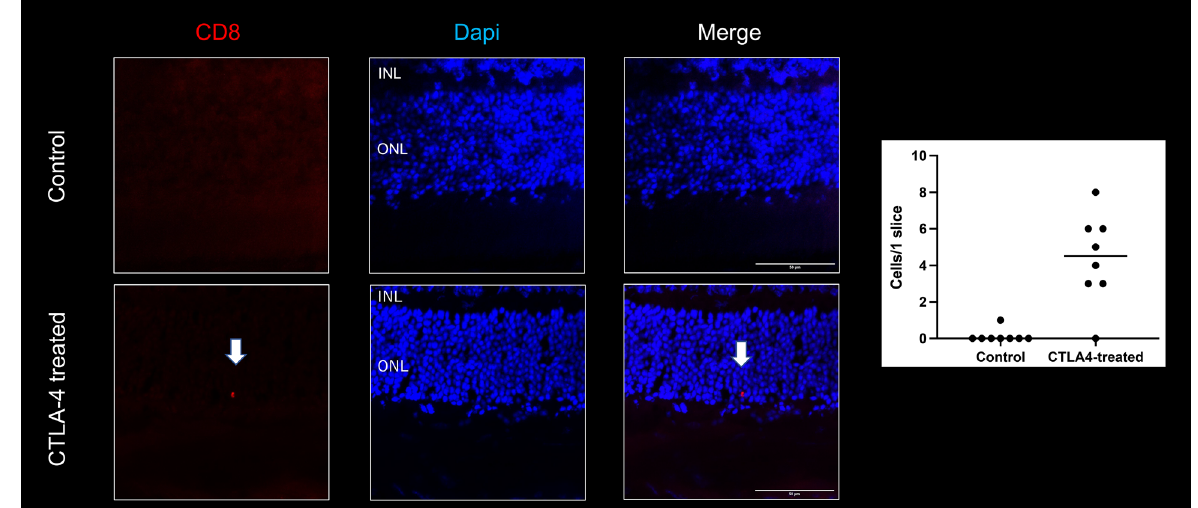
Figure 8. CD8 staining in control and anti-CTLA4-treated eyes (n = 4 in each group). CD8-positive cells were observed in treated eyes, by contrast very limited those cells were detected in the control. There was a significant difference in the number of CD8-positive cells in the retina between control and treated eyes. ONL: Outer nuclear layer, INL: Inner nuclear layer. Averaged